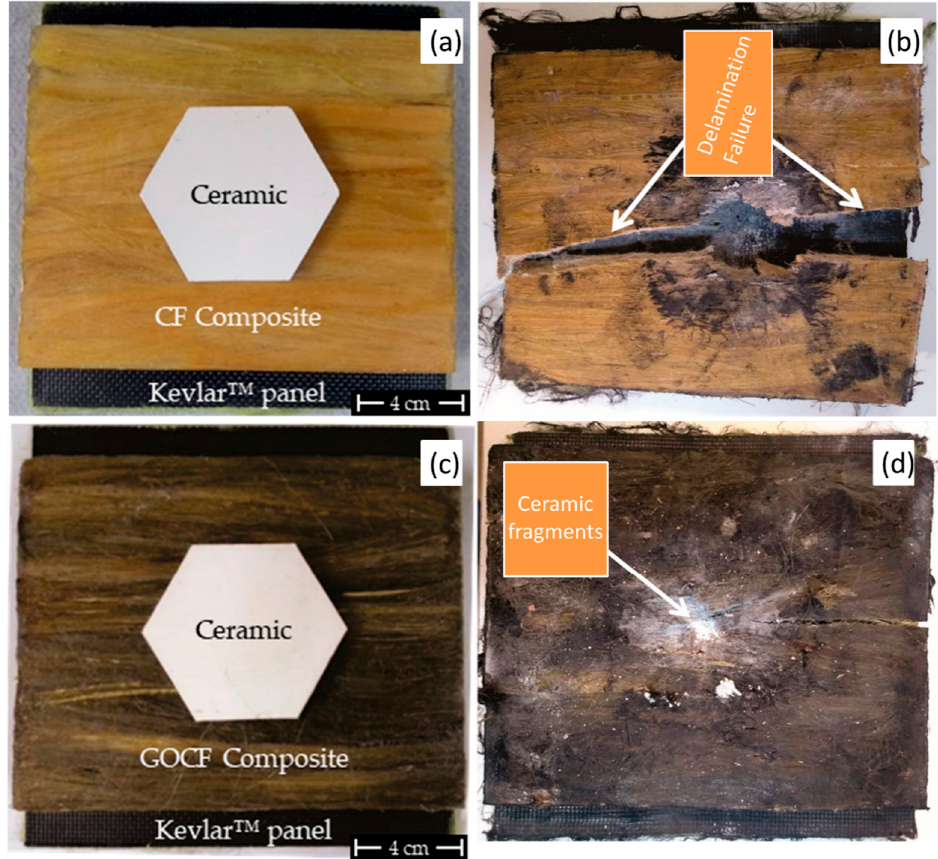
Figure 12. Multilayer armor system using curaua / epoxy composites as second layer: ( a ) CF before test, ( b ) CF after test, ( c ) GOCF before test, and ( d ) GOCF after test. Adapted from [51].